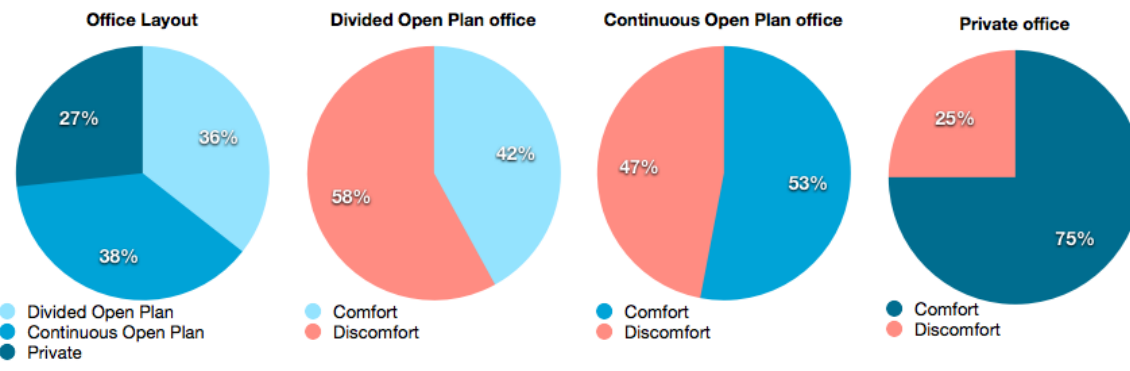
Figure 4. Question: In general, how satisfied are you with your office?